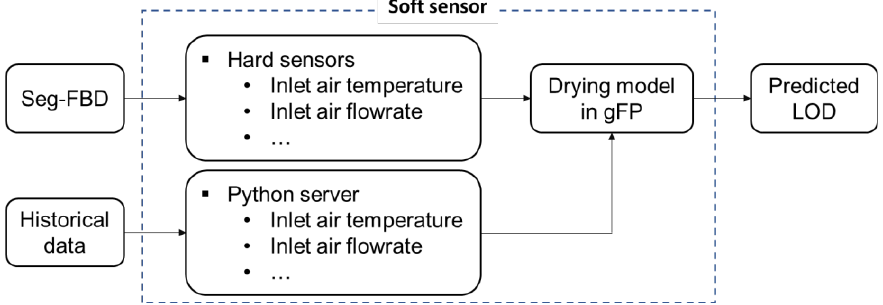
Figure 3. Schematic diagram of a soft